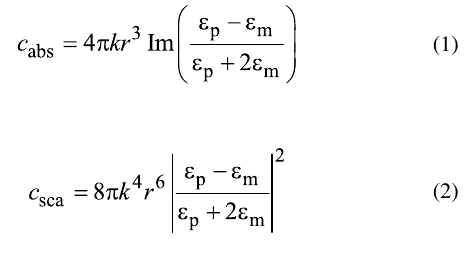
[26], this behavior is different from conventional high-order